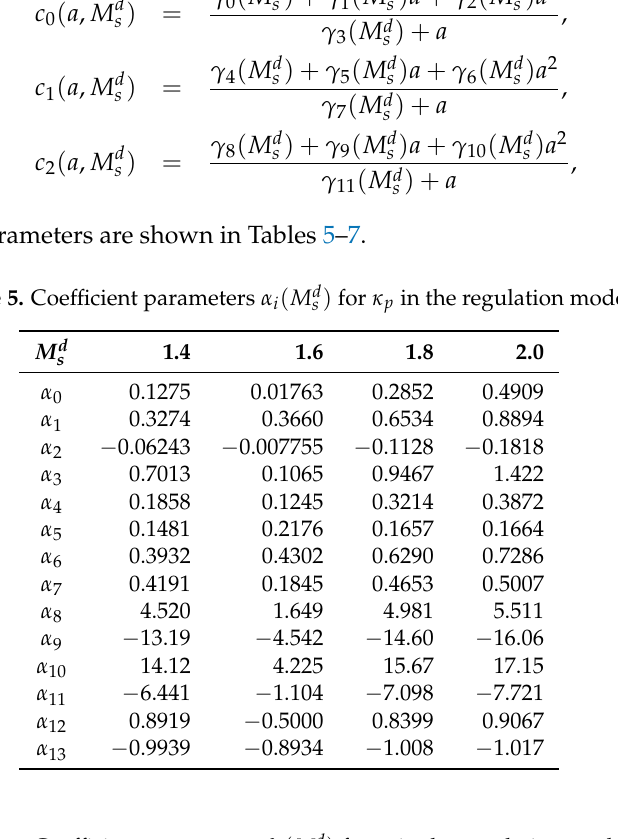
Table 6. Coefficient parameters β i ( M d s ) for τ i in the regulation